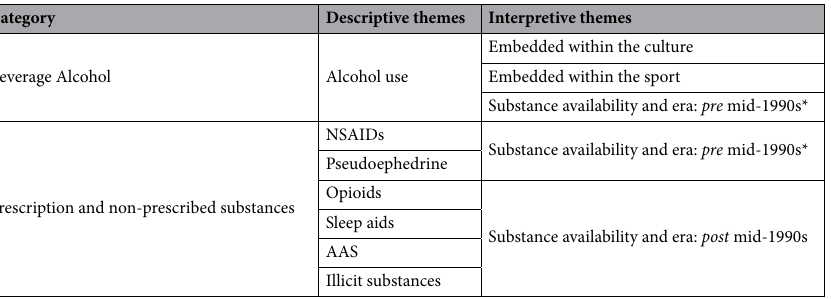
Table 1. Thematic organisation based on comments associated with substance use patterns as well as descriptive and interpretive themes. Frequencies for descriptive themes are shown in Fig. 1. Asterisk* indicates an era where the substance was prevalent for use in the dressing rooms on during team travel. NSAIDS = non- steroidal anti-inflammatory medications; AAS = androgenic anabolic